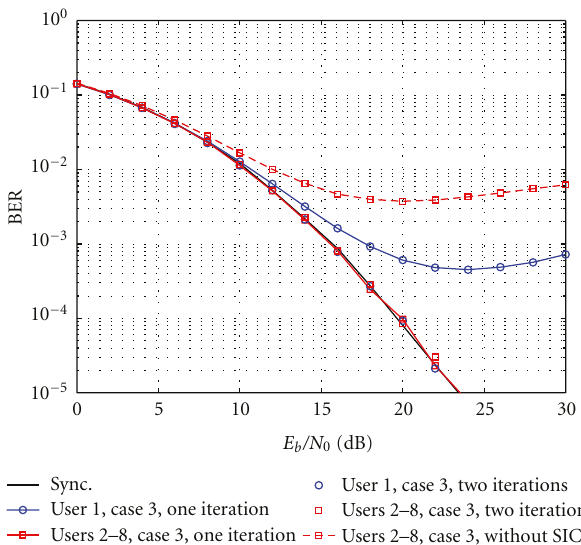
Figure 9: BER performance of each user, τ 1 = 0, τ 2 = ··· = τ 8 = 7.